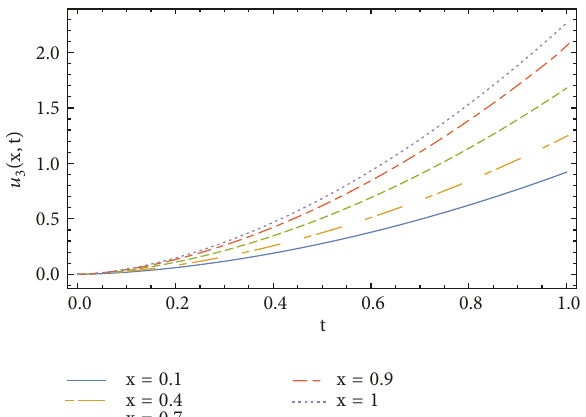
Figure 3: The 3-term FRDTM solutions 𝑢 3 for 𝑥 = 0.1,0.4,0.7, 0.9,1;𝛼 = 0.8 ; 𝑡 ∈ [0, 1]